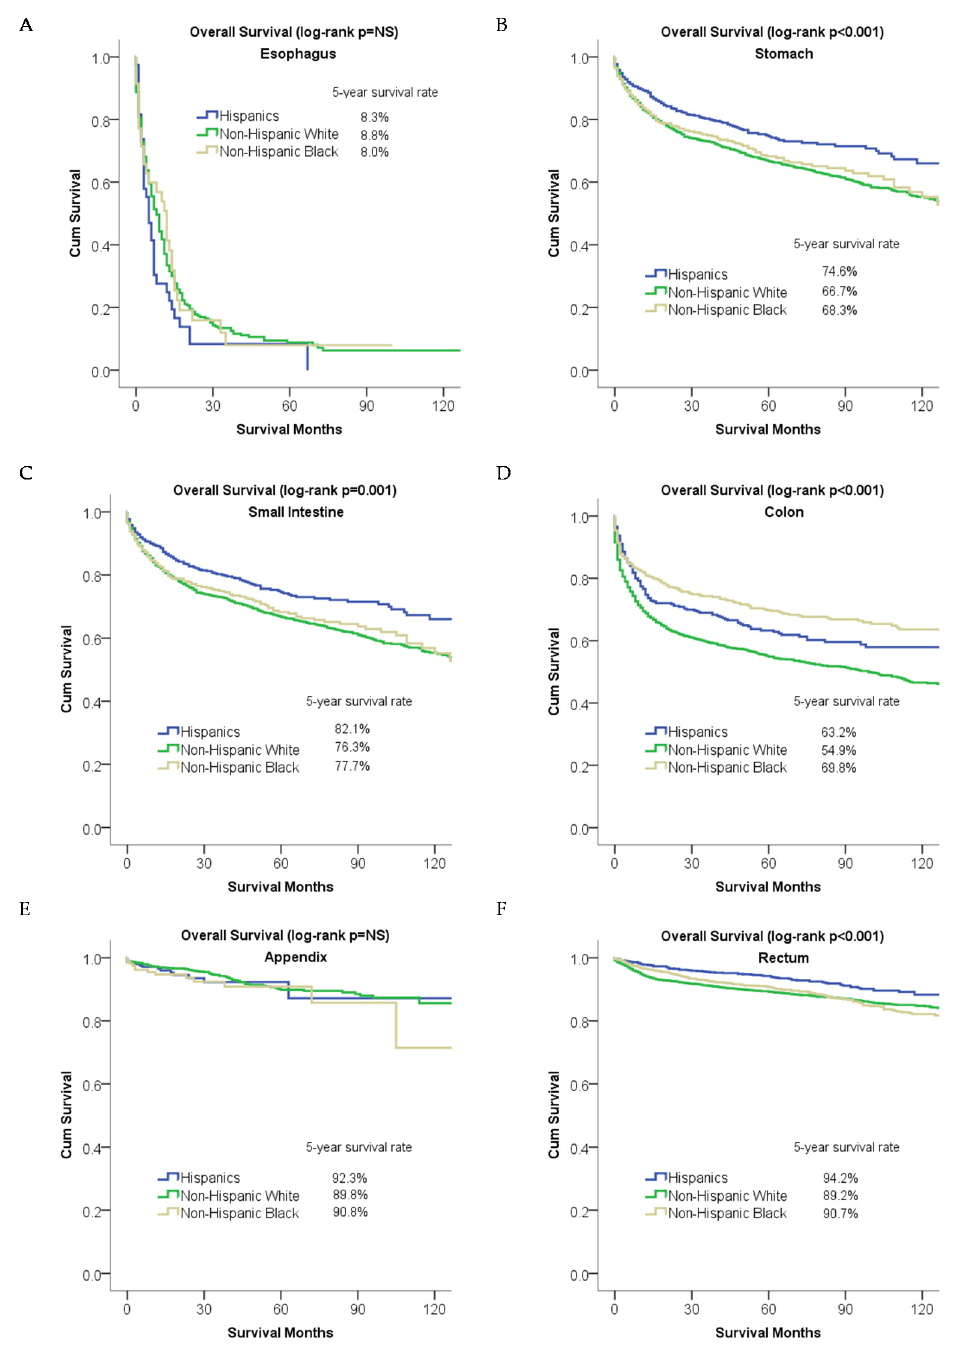
Figure 3. Racial disparities in overall survival for patients stratified by primary site: ( A ) esophagus, ( B ) stomach, ( C ) small intestine, ( D ) colon, ( E ) rectum, and ( F ) appendix.